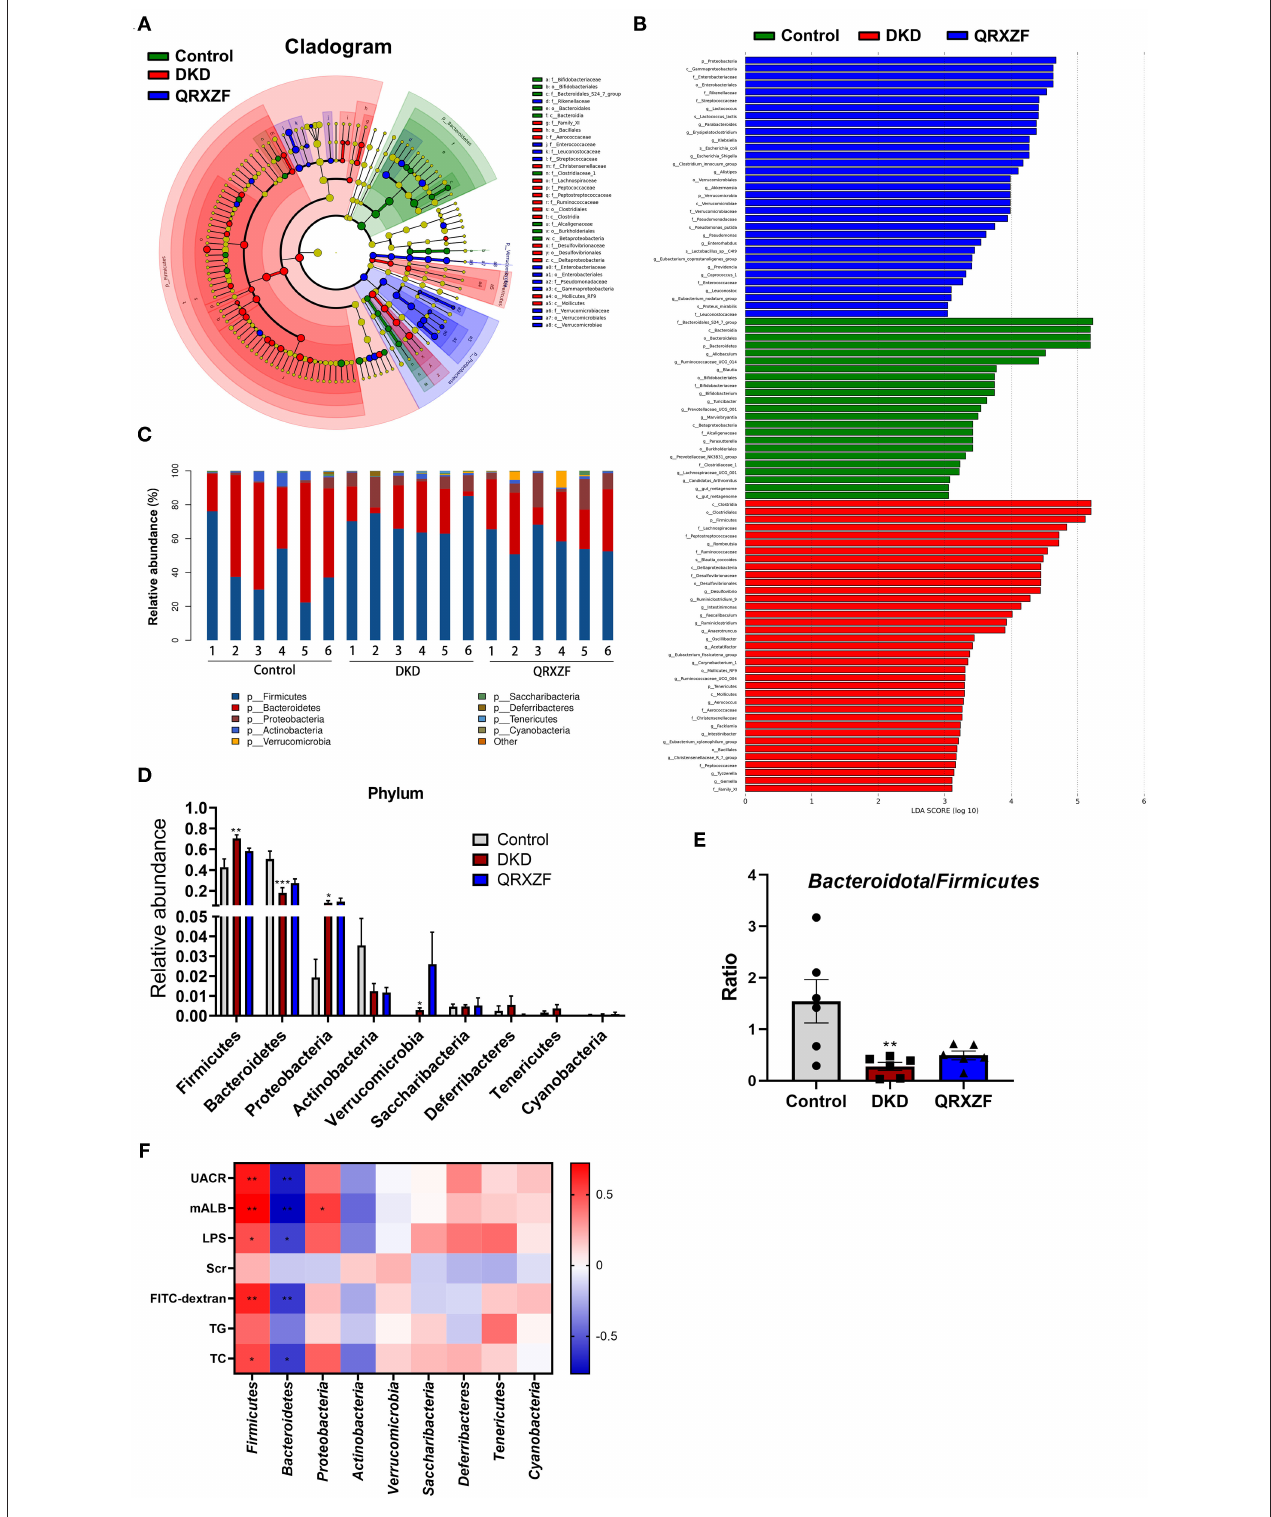
FIGURE 5 | Key biomarkers of gut microbiota between each group. (A) Taxonomy analysis; (B) LEfSe analysis; (C) Relative abundance at phylum level; (D) Relative abundance at the phylum level between three groups; (E) Bacteroidetes -to- Firmicutes ratio ( n = 6, means ± SEM); (F) Correlation analyses between